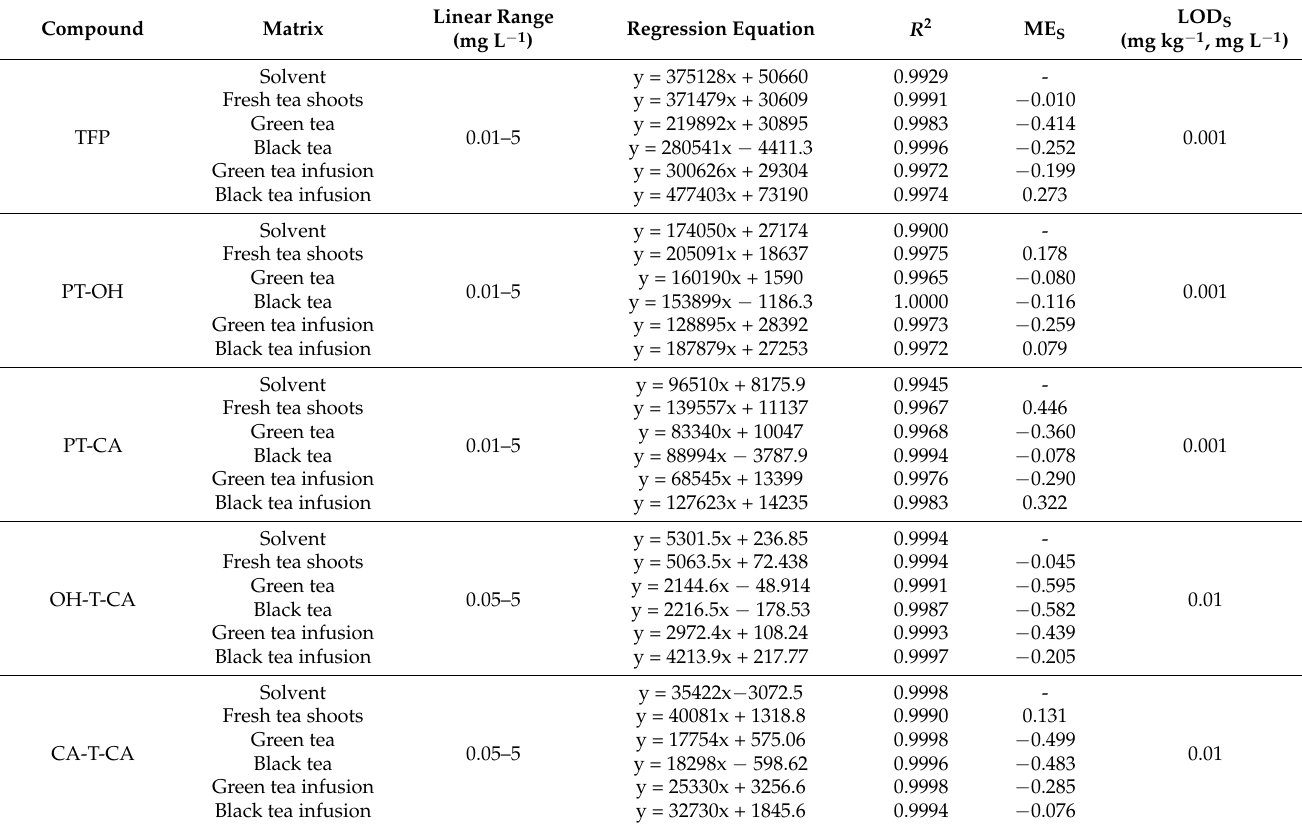
Table 3. The linear equations, correlation coefficient ( R 2 ), matrix effects (MEs) and limits of detection (LODs) of TFP and its metabolites in different tea